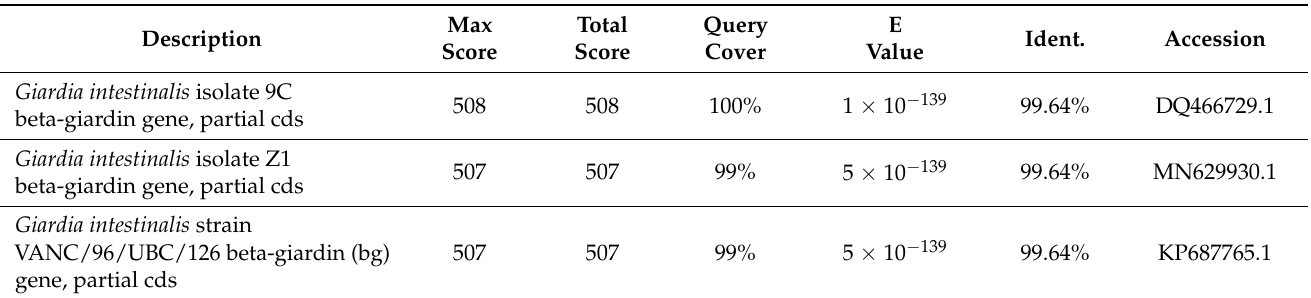
Table A2. BLAST results for the sequence obtained by PCR amplification of the G. duodenalis β -giardin gene (primer